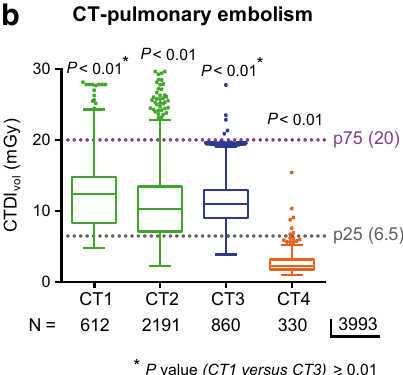
Fig. 3 Detection of differences in dose levels used in different hospitals for similar anatomical regions by dose-tracking systems illustrating that different hospitals are using the highest dose depending on the anatomical region involved. a Box plot of the CTDI vol -median value, interquartile range, total range and outliers for all CT-head examinations on the five CTsystems with the national P75 and P25 DRLs as benchmark, showing hospital B has the highest CTDI vol . p values (all < 0.01) are the result of comparing the mean rank of each CTsystem with the mean rank of each